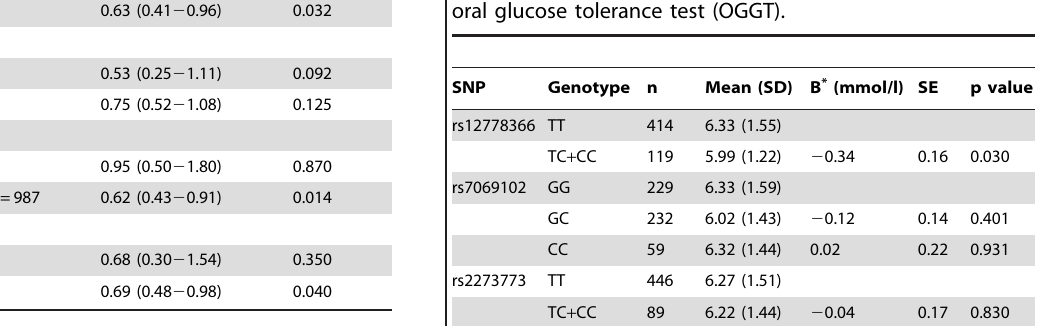
Table 2). Survival curves according to genotypes of rs12778366